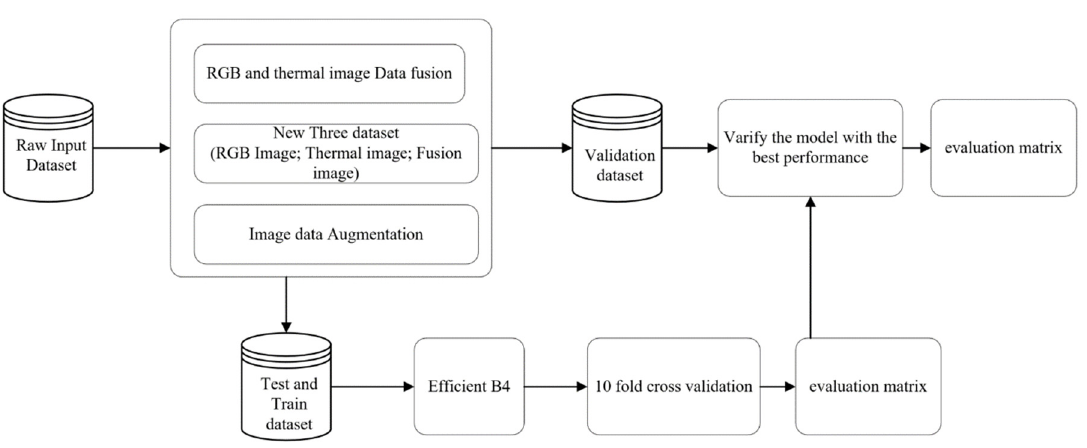
Figure 1. Work flow of proposed work.